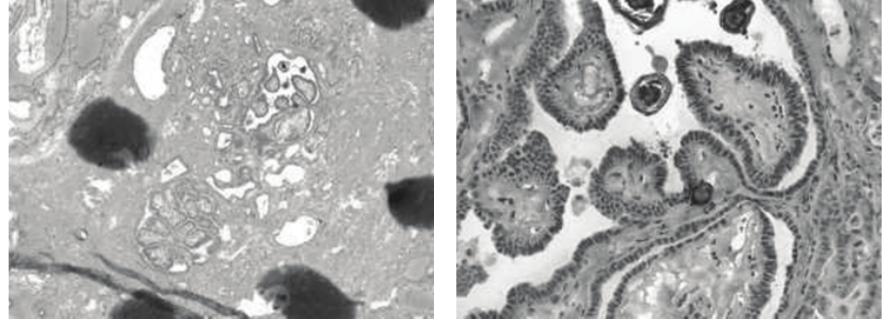
Figure 3: Histopathology of lingual thyroid tissue demonstrating papillary thyroid